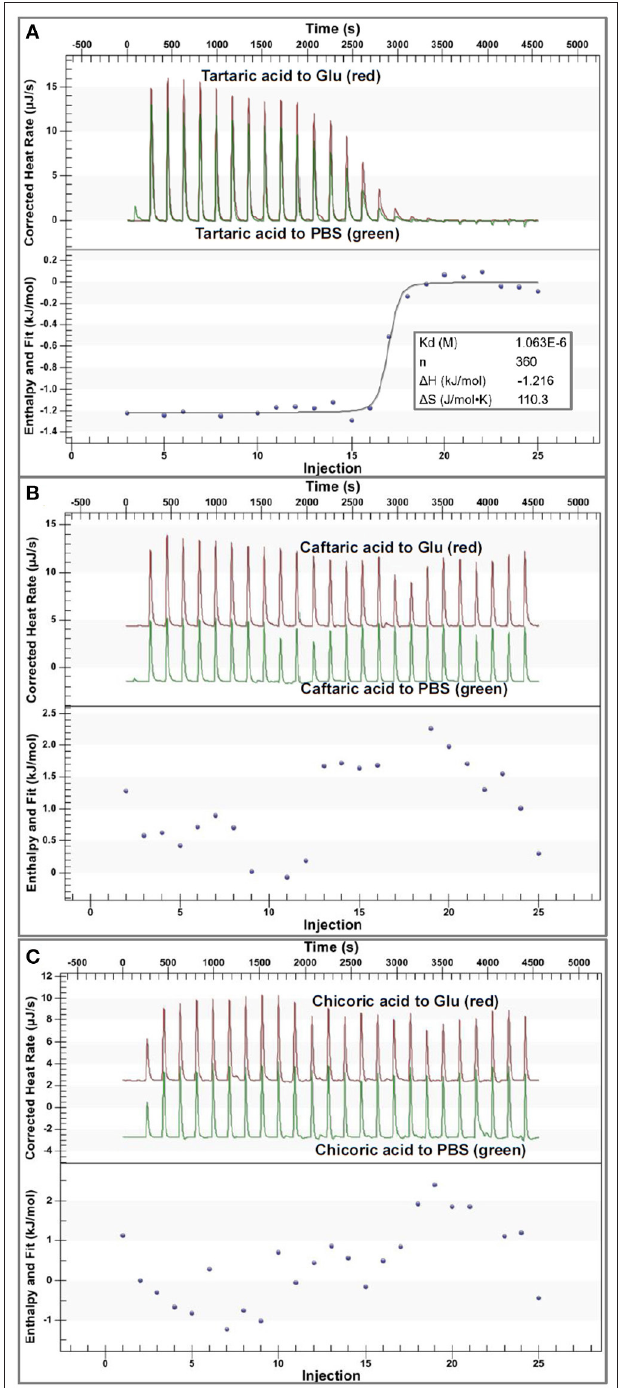
FIGURE 4 | The ITC data for binding interactions of tartaric acid (A) , caftaric acid (B) and chicoric acid (C) with α -glucosidase. In each figure, the upper section indicates the heat flow for titration of organic acids to α -glucosidase solution (the read peak curves) and the heat flow for titration of organic acids to buffer (the green peak curves), and the lower section of (A) indicates the fitted plot of the enthalpy changes against injection order using an independent binding model. The input molar ratio of tartaric acid to α -glucosidase was modified within the available range to make the model fit the curve